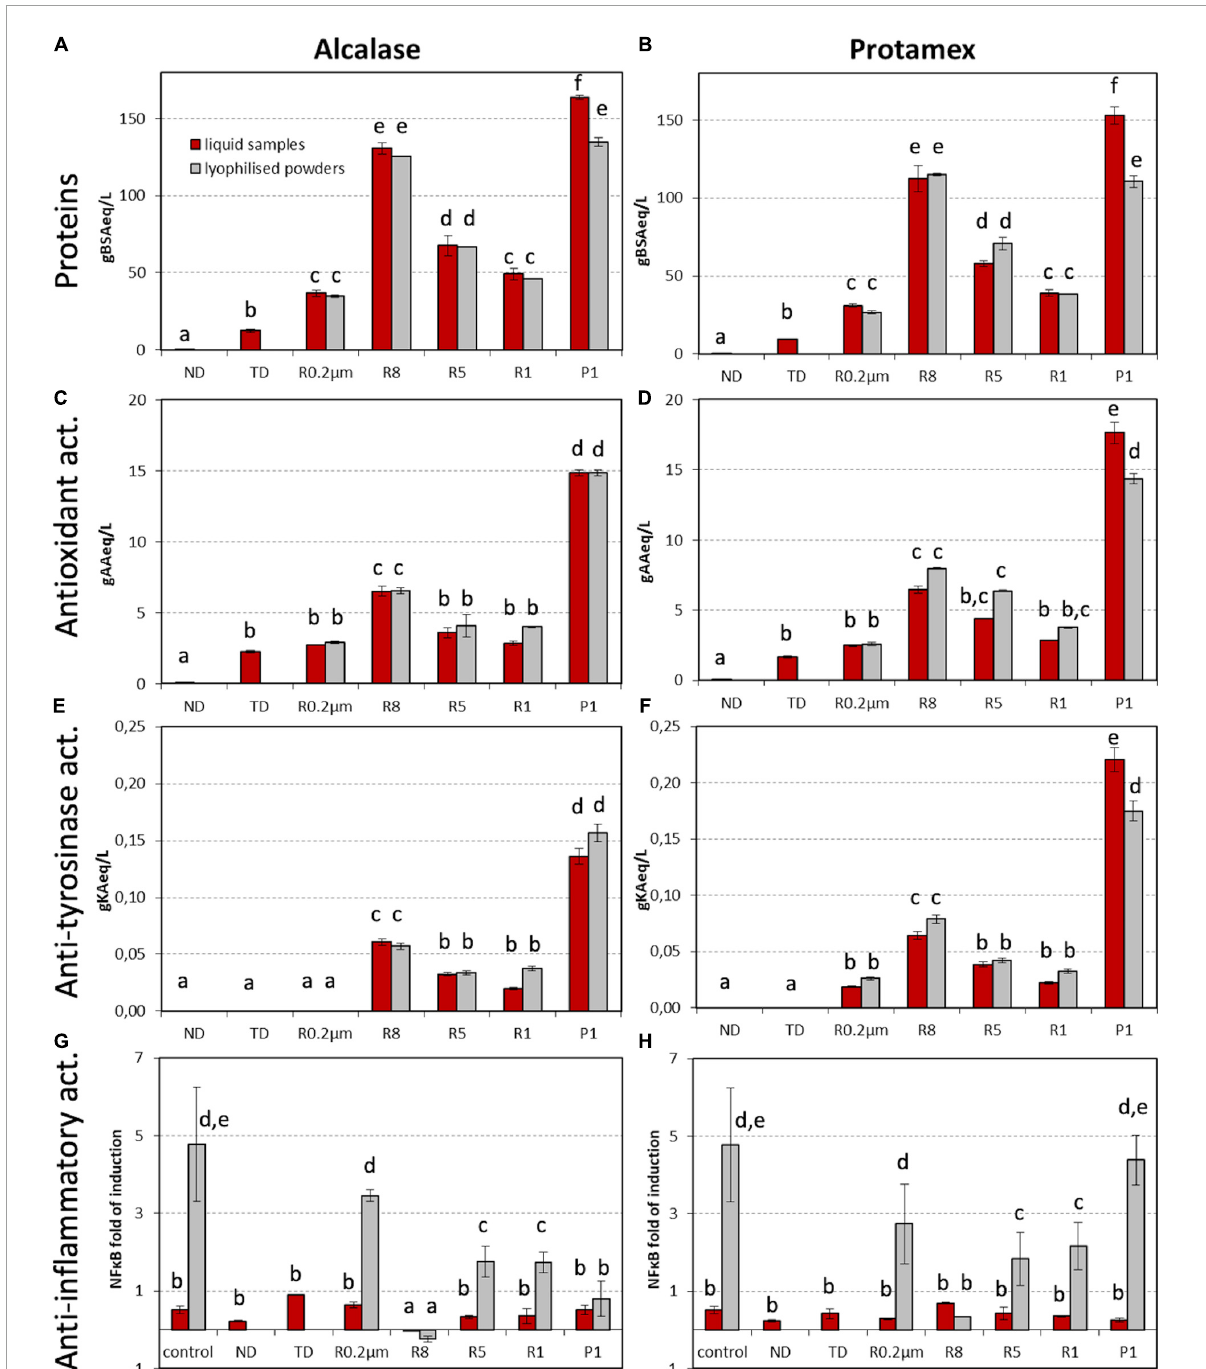
FIGURE2 (A,B) Protein content, (C,D) antioxidant, (E,F) anti-tyrosinase, and (G,H) anti-inflammatory activities in (A,C,E,G) Alcalase and (B,D,F,H) Protamex processes at 55 ◦ C, 120 min, 0.5 U enz/g proteins, 2 L reaction volume (condition 5). Data of liquid samples and of related lyophilized powders are reported; lyophilization was not performed on ND and TD. Fractions were named as follows: ND, not digested initial by-product; TD, total digestate condition 5; retentates of 0.2 µ m (R 0.2 µ m), 8 kDa (R8), 5 kDa (R5), and 1 kDa (R1), and 1 kDa permeate (P1). Spectrophotometric results are expressed as g of standard compound (BSA, bovine serum albumin; AA, ascorbic acid; KA, kojic acid) equivalent per liter. Cell-based assay results are expressed as fold of NF κ B induction in presence of TNF α ; results are corrected according to cell viability. Data represent the mean ± SD ( n = 3). Different letters indicate a statistically significant difference (one-way ANOVA test followed by post hoc corrected two-tailed Tukey test, p < 0.05) between the same type of data (proteins, antioxidant, anti-tyrosinase, and anti-inflammatory activities), from the lowest (a) to the highest